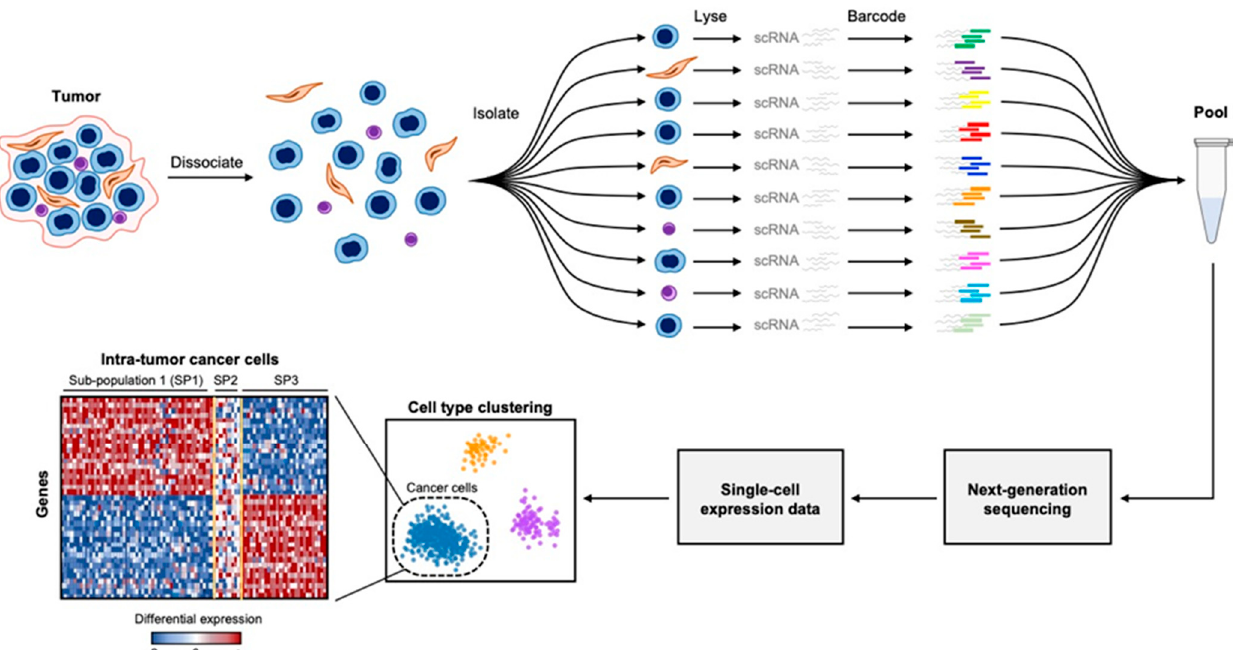
Figure 1. Overview of single-cell RNA sequencing. Tumor tissue is disaggregated into constituent single cells which can be isolated through various methods. Isolated single cells are lysed, and cellular RNA is converted into cDNA. cDNA from individual cells is ligated to cell-specific oligonucleotide barcodes after which all cDNA is pooled and sequenced collectively via next-generation sequencing. The transcriptomes of each cell are then segregated computationally using the barcode sequences, enabling the analysis of single-cell gene expression profiles.